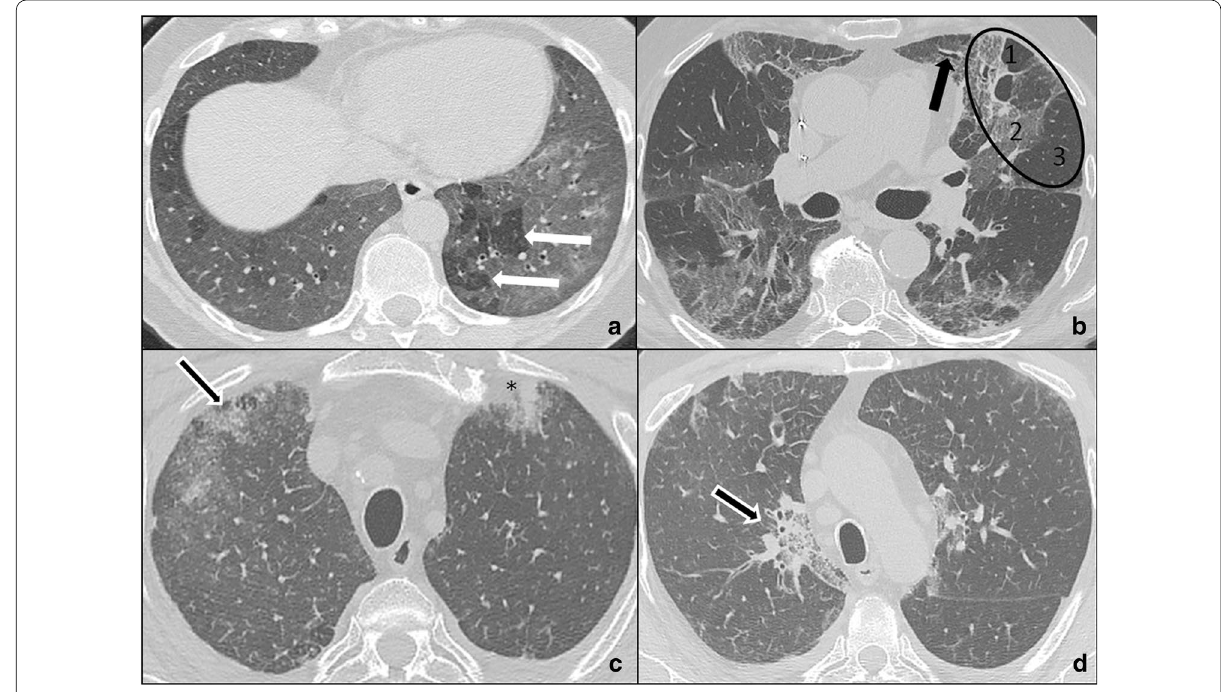
Fig. 4 a – d COVID-19 pneumonia differential diagnoses: hypersensitivity pneumonia and eosinophilic pneumonia. HRTCs of a patient affected by hypersensitivity pneumonia at baseline ( a ) and after two years ( b ): acute/subacute hypersensitivity pneumonia is characterised by diffuse ground-glass opacities clearly demarcated from air trapping areas (white arrows in a ); chronic hypersensitivity pneumonia presents with architectural distortions and traction bronchiectases (black arrow in b ). The triad of mosaic oligemia (1 in b ), ground-glass opacities (2 in b ) and normal pulmonary parenchyma (3 in b ) is defined as “headcheese sign” (black oval in b ). HRTC of acute eosinophilic pneumonia ( c , d ) showing confluent crazy paving opacities (white bordered black arrows in c , d ) coexisting with consolidations (black asterisk in c ) and slight bilateral pleural